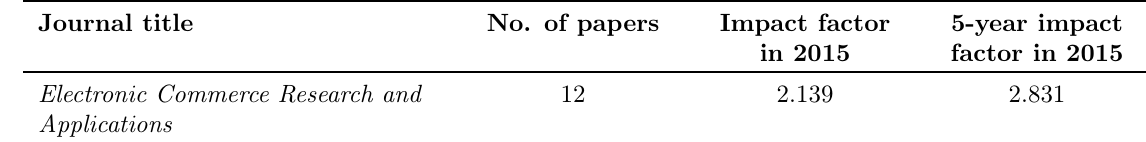
Table 4. Journals that publish research on the mobile